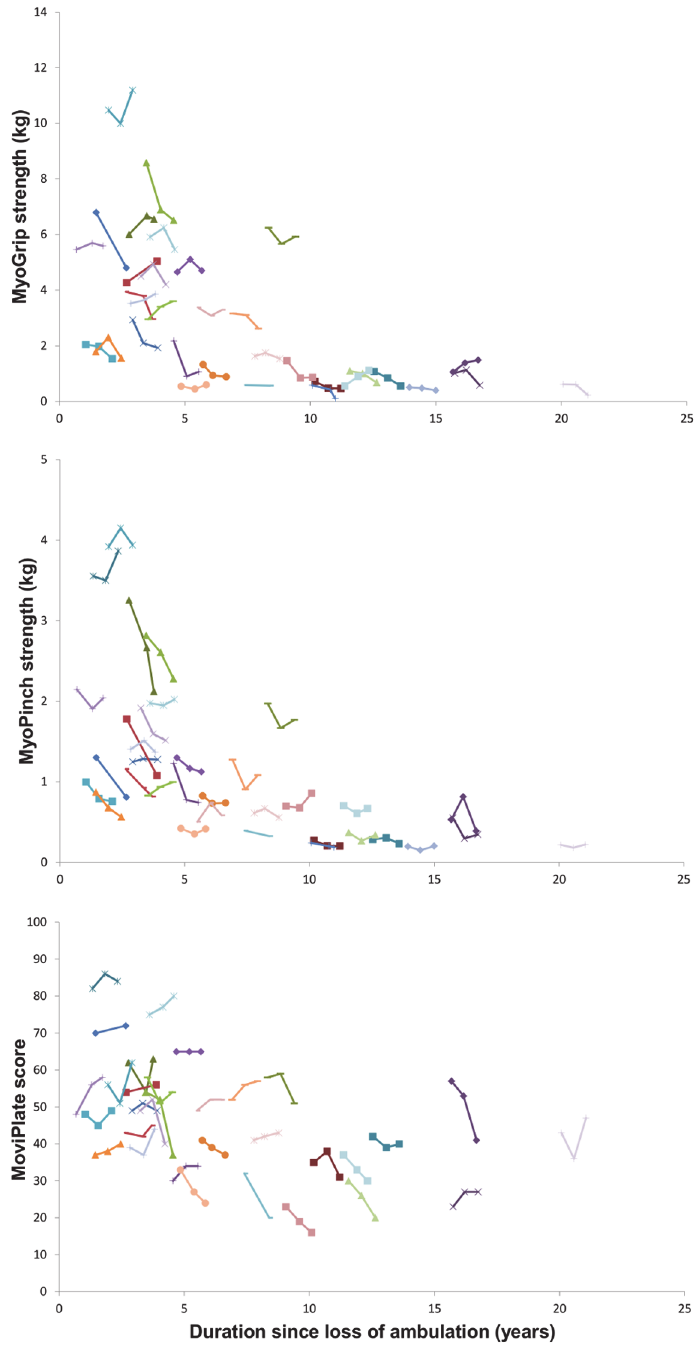
Figure 3. Relation between MyoSet values at baseline, at 6 months, and at one year with duration since loss of ambulation.